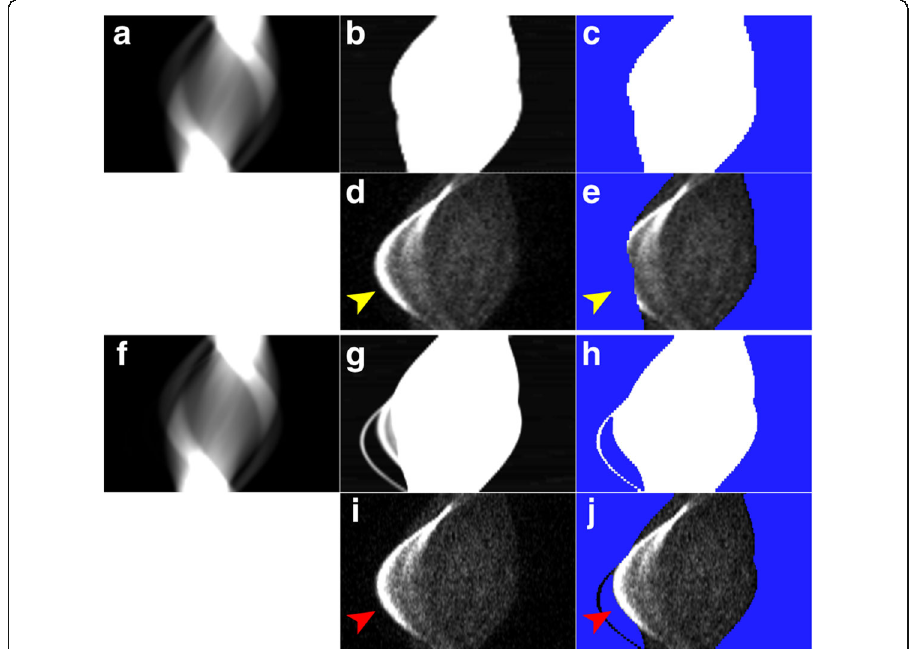
Fig. 5 Sinogram images on 4-mm ( a – e ) and 2-mm ( f – j ) voxel size (tube curve pattern). μ -map sinogram ( a , f ), changing display scaling of a , f ( b , g ), mask for TF-SSS algorithm ( c , h in blue ), random-corrected emission ( d , i ), and mask superimposed on the emission sinogram ( e , j ). The urinary catheter was masked in the 4-mm voxel size μ -map sinogram ( yellow arrows ), but not in the 2-mm voxel size μ -map sinogram ( red arrows